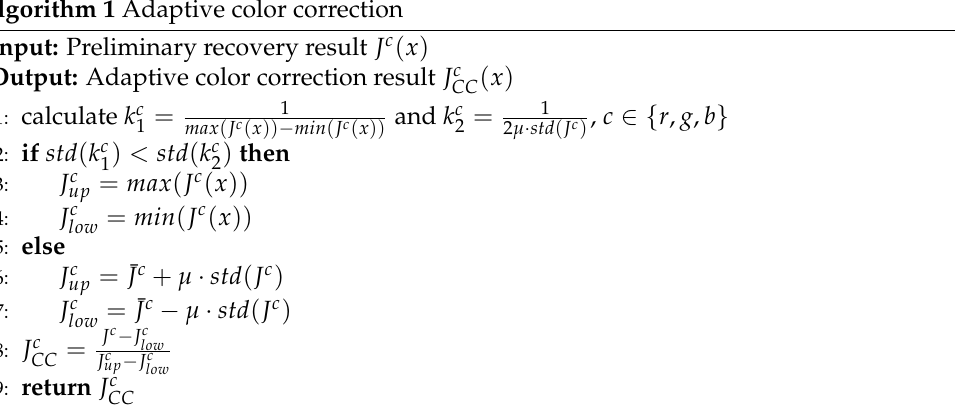
Algorithm 1 Adaptive color